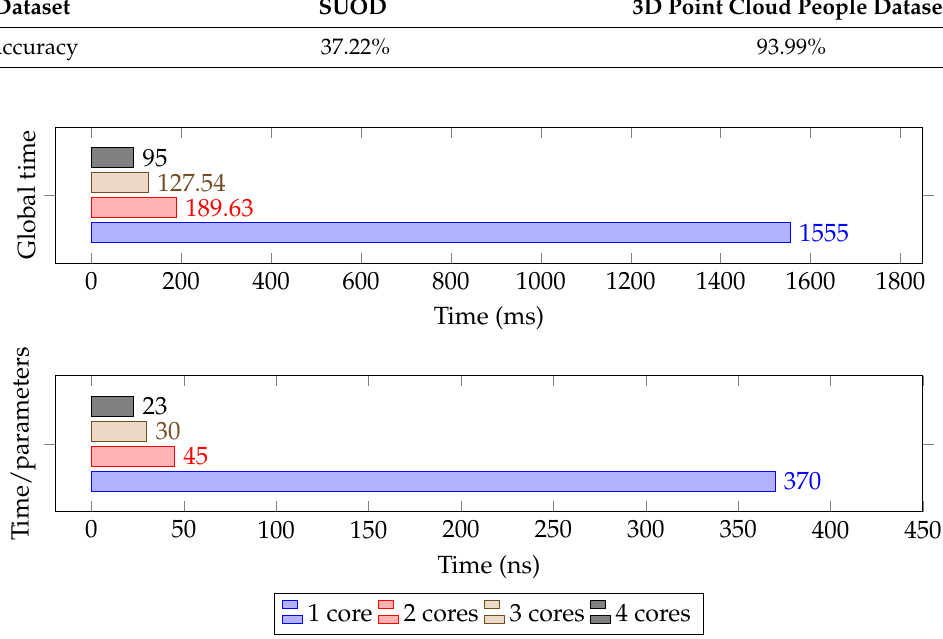
Figure 11. Time performance and time per parameter for the SUOD neural network